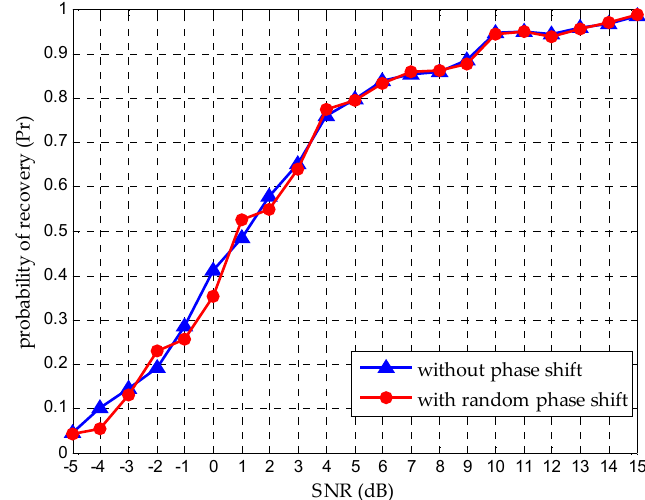
Figure 5. Comparison of P r under random phase shift and no phase shift when 6 N .